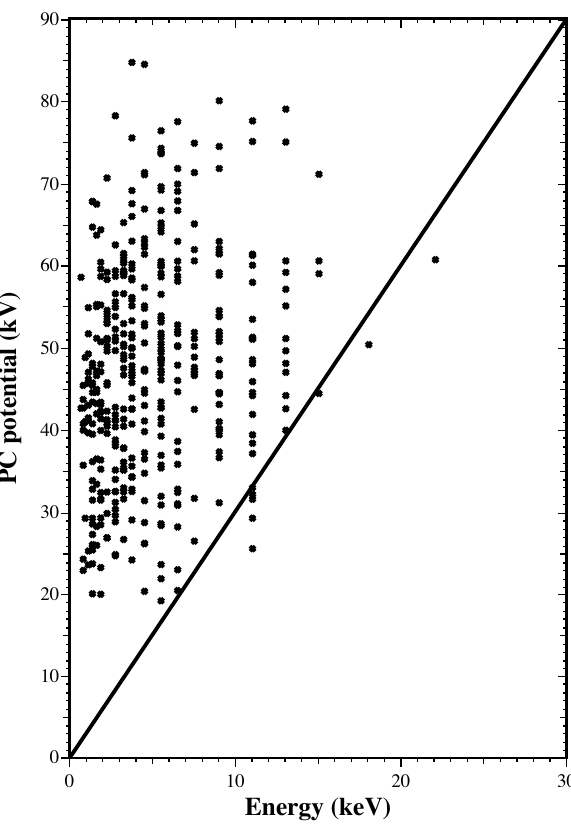
Fig. 7. Distribution of Kp index values related to the inverted-V’s. The inverted-V’s are typically recorded during quiet times or mod- erate magnetic activity (Kp 1–4). The distribution is divided by the occurrence frequency of each Kp value in a randomly selected data set.